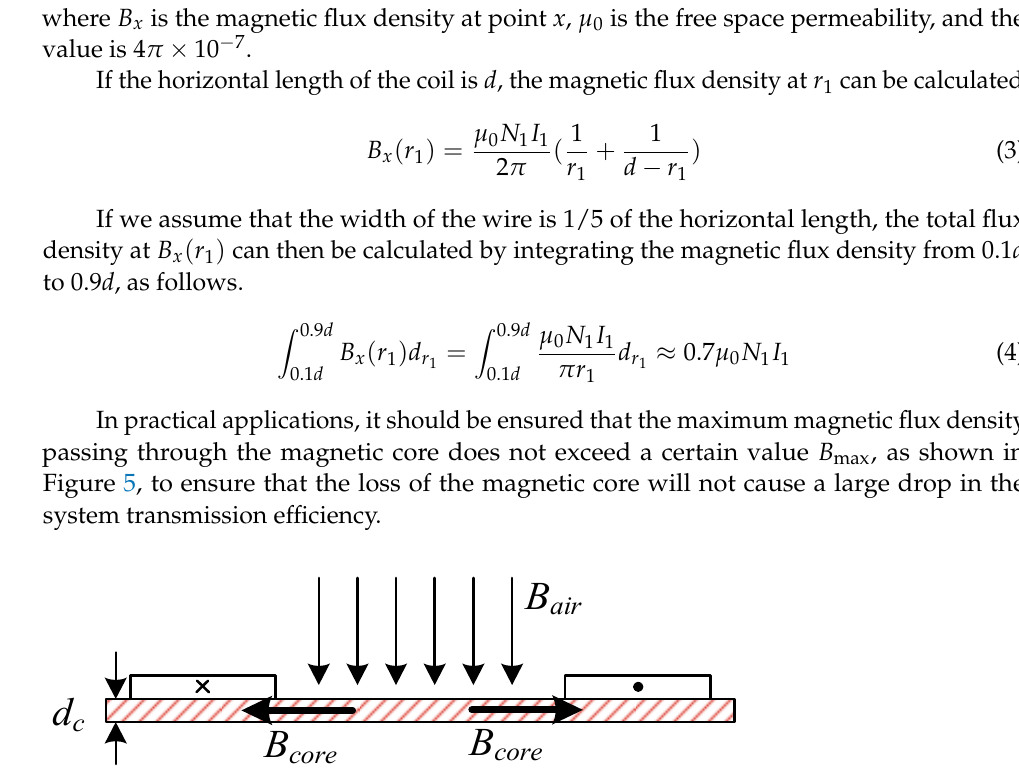
Figure 5. The magnetic flux density of the magnetic core.